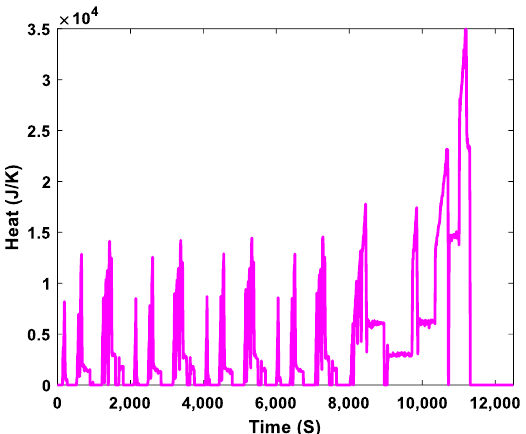
Figure 9. Heat fluctuations in the internal combustion engine.